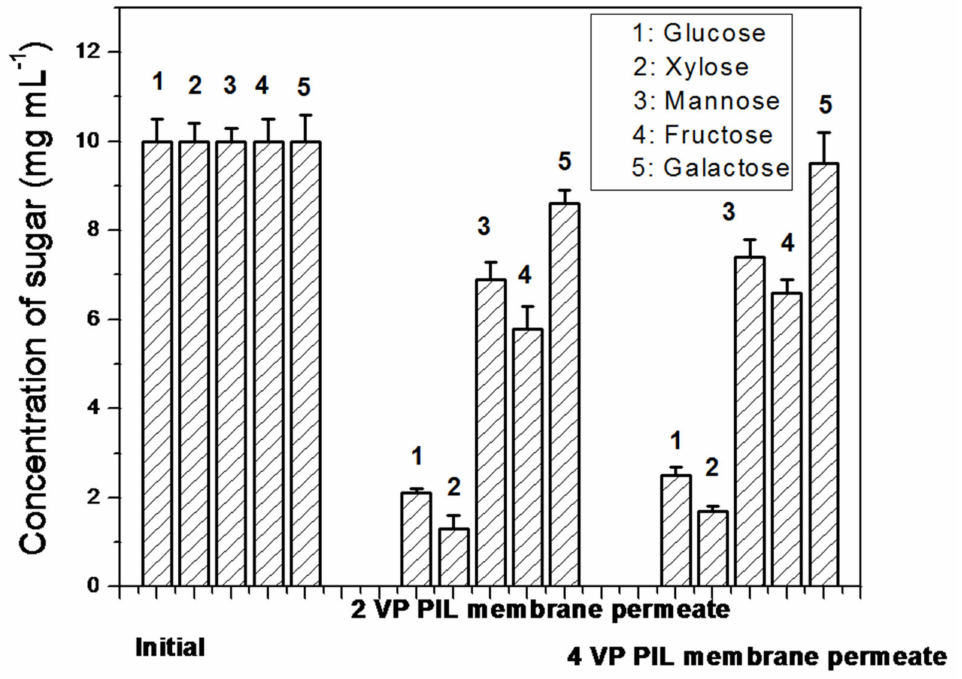
Figure 11. The concentrations for the sugar in initial feed and the permeate solutions obtained by filtration through PIL augmented